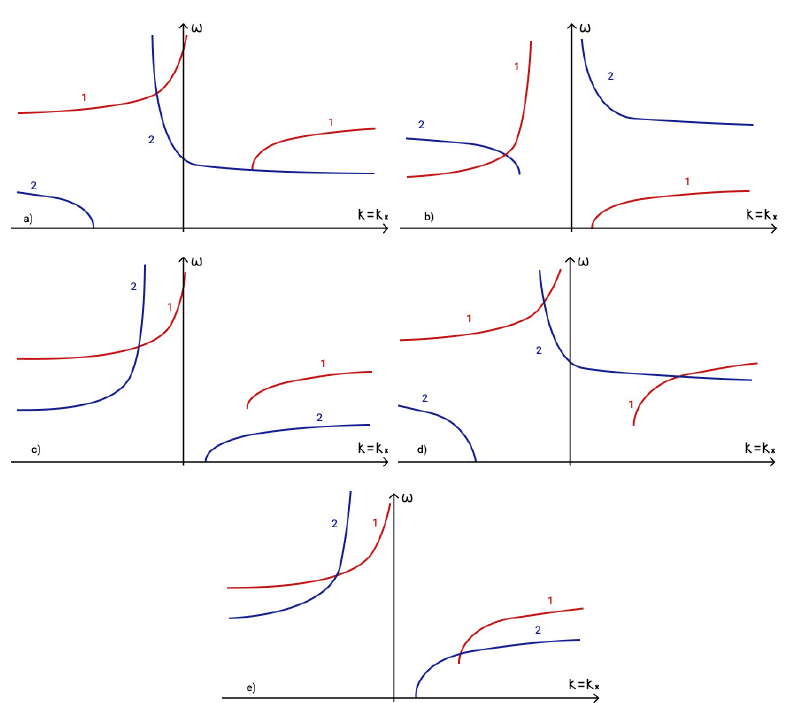
Figure 18. Phase matching conditions for ( a ) two magnetic inertia gravity waves and one magne- tostrophic wave: 1— ω = ω mstr inertia gravity waves and one magnetostrophic wave: 1— ω = ω mstr ) + ω ( k x ) , ( c ) two magnetostrophic waves and one magnetic inertia gravity wave: 1— k x mig Bz c c one magnetic inertia gravity wave: 1— ω = ω mig ( e ) three magnetostrophic waves: 1— ω = ω mstr